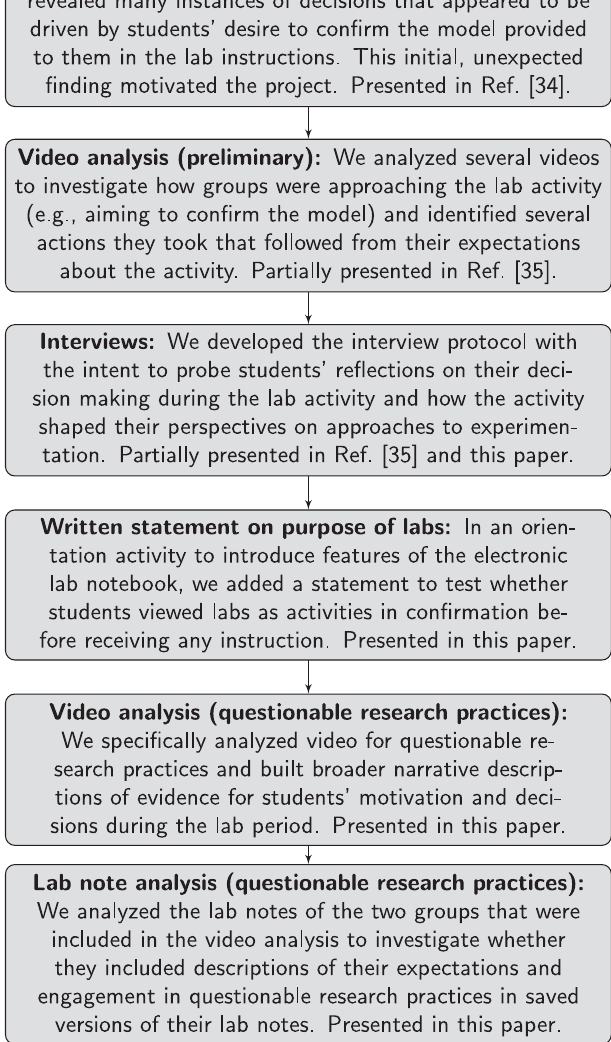
FIG. 1. Order of data analysis for transparency. The results are communicated for ease of understanding by the reader and do not reflect the order of data